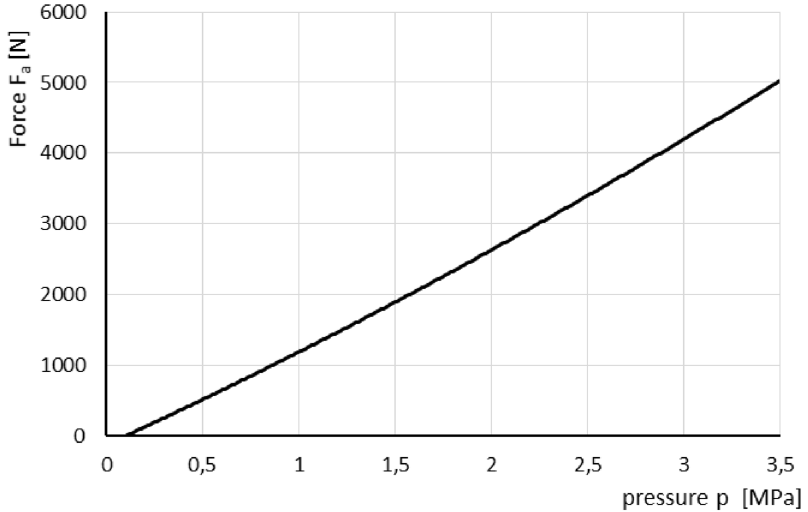
Figure 10. Characteristic of axial force applied to the piston 13